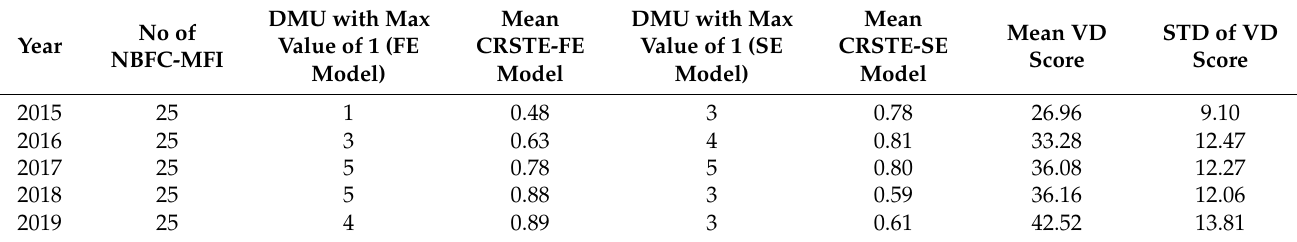
Table 5. Technical efficiency of NBFC–MFI and mean VD score from